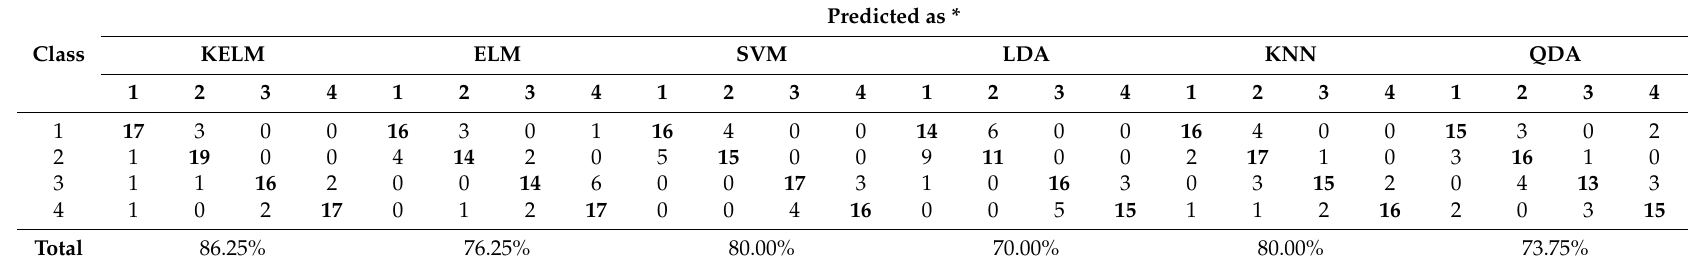
Table 1. Classification results of peak value.